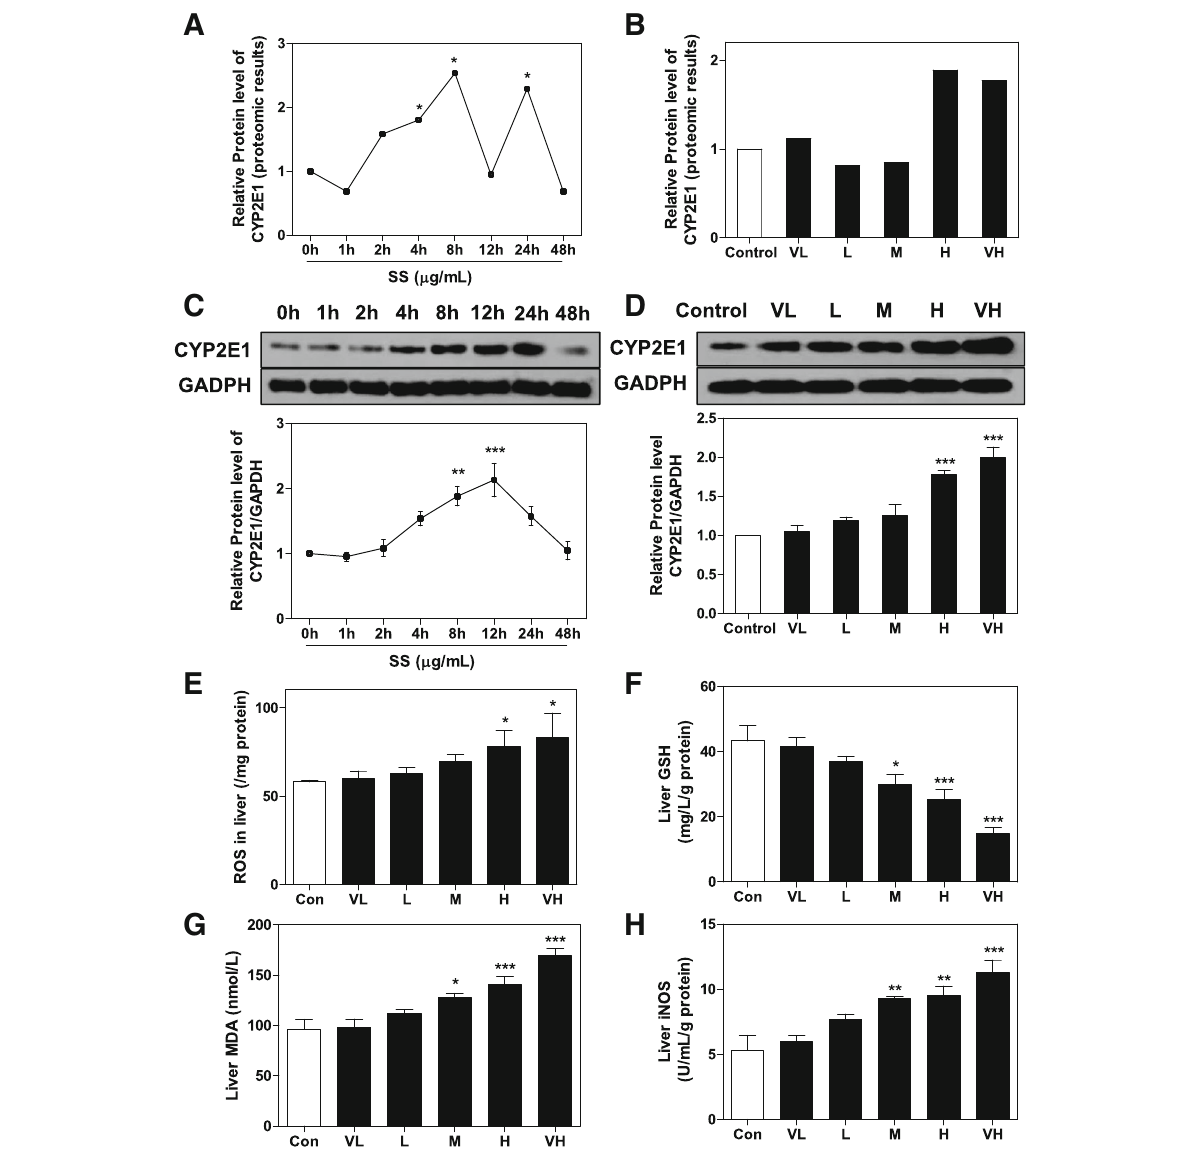
Fig. 7 SS-induced oxidative stress in mice liver. Proteomic results for CYP2E1 expression in a time-toxicity study and b dose-toxicity study. * p value < 0.05. Proteins levels of CYP2E1 in c time-toxicity study and d dose-toxicity study were determined by western blot. Representative images of immunoblots are shown and analyzed using GAPDH as loading control. Effects of different dose of SS administration on e ROS, f GSH, g MDA and h iNOS level in liver. All results are presented as mean ± S.E. ( n = 8), * p < 0.05 , **p < 0.01 , ***p < 0.001 , compared to vehicle control